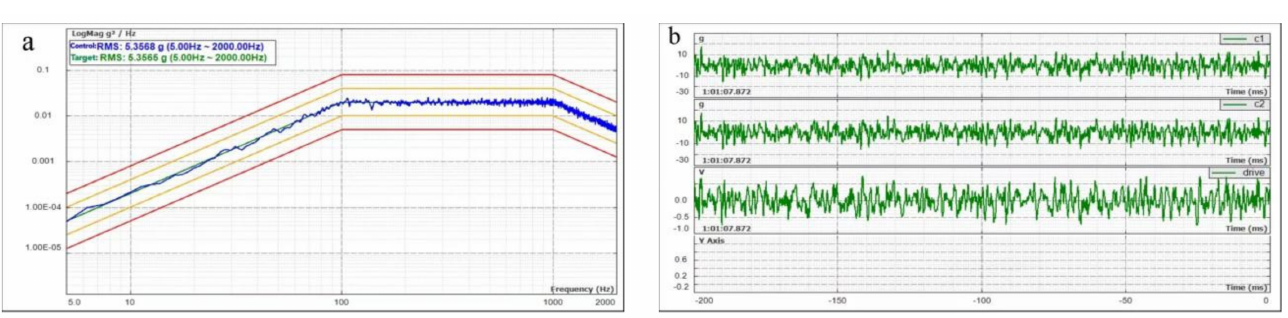
Figure 9. Frequency conversion vibration control spectrum ( X -axis). ( a ) Control chart of power spectral density varying with frequency ( b ) Vibration time history.